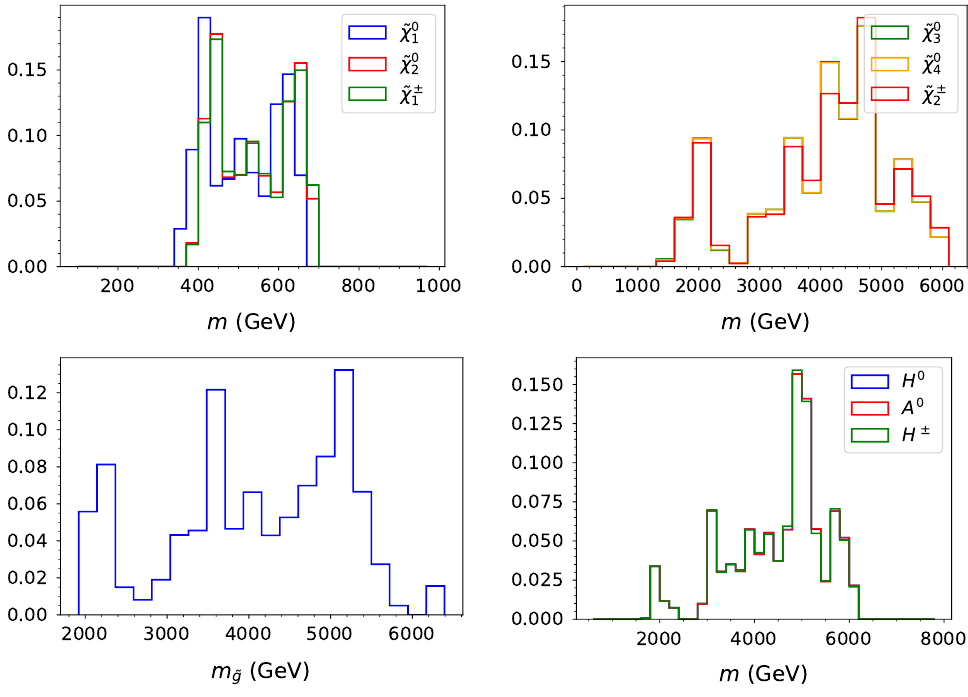
Figure 11 . Distribution of the masses of the gauginos and higgses. The mass spectrum of the lightest chargino and two lightest neutralinos is compressed to provide co-annihilation mechanism for dark